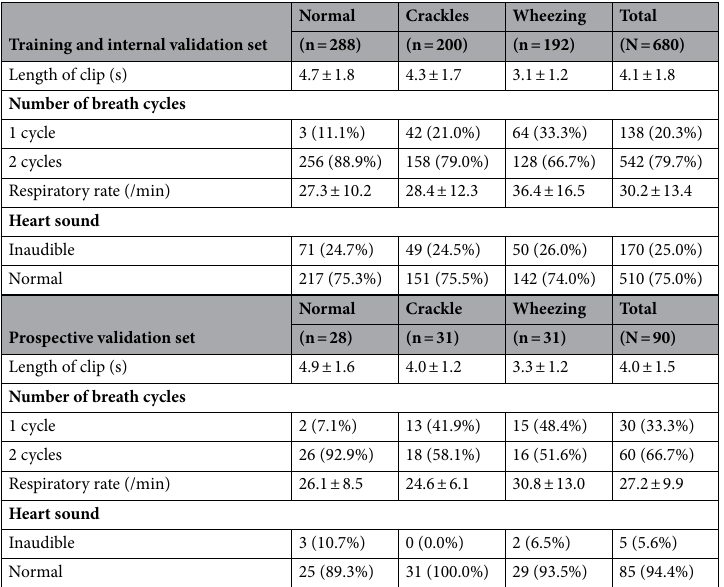
Table 1. Data characteristics of lung sound clips in the training and internal validation set and the prospective validation set.